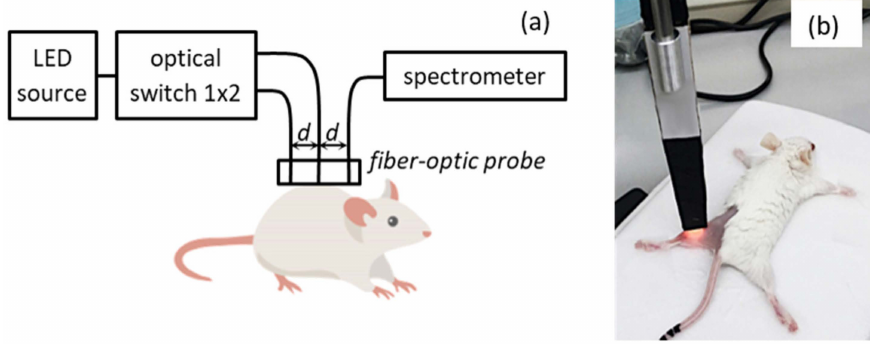
Figure 2. Schematic of the DOS setup ( a ) and a photo of DOS measurement procedure ( b